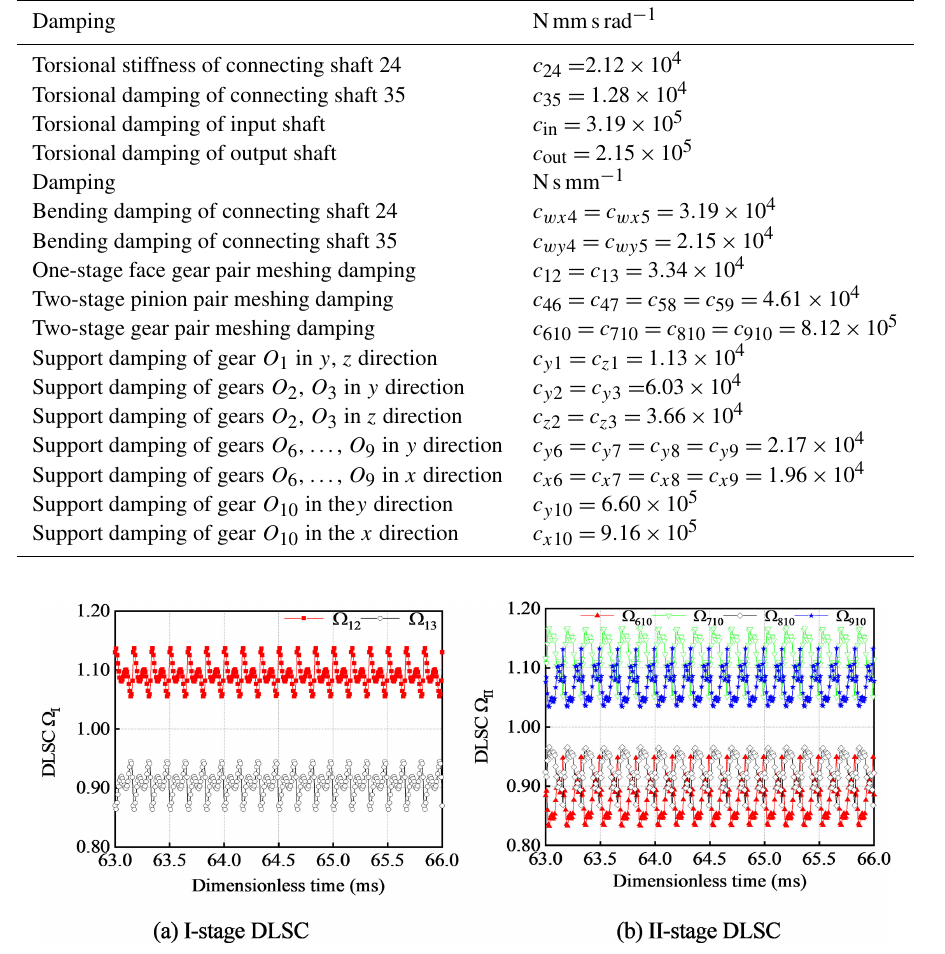
Figure 10. DLSC changed with dimensionless